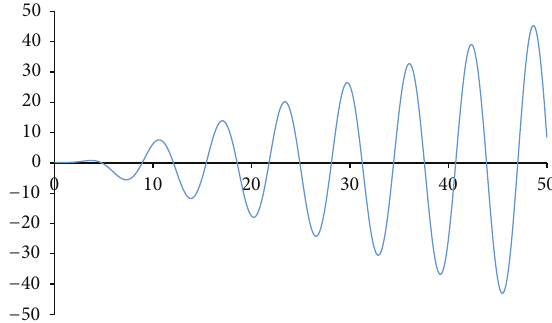
Figure 2: The numerical solution 𝑥(𝑡) for 𝑒(𝑡) = 𝑡 4 sin (𝑡) , 𝛼 = 1 and initial conditions 𝑥(0) = 0.1 , 𝑥 󸀠 (0) = 0.1